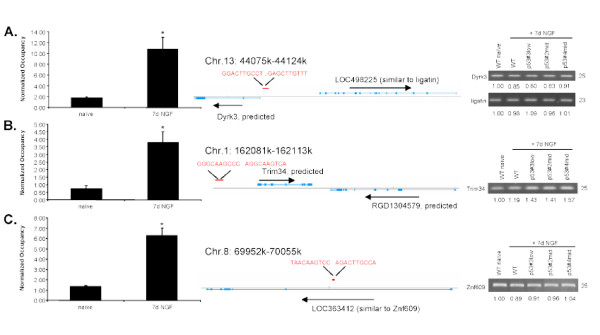
Additional targets with NGF-dependent increase in p53 occupancy, but where p53-dependent transactivation could not be clearly determined using anti-p53 shRNA expressing cell lines. Panels A-C show site-specific qPCR ChIP results on left with standard deviation, where significance at p ≤ 0.05 is designated by an asterisk (*). GAPDH controls in Figure 7 also apply to gene expression analyses in Figure 8. Note the p53-occupied sequence in Panel A lies between genes which were both examined for changes in expression. Display and analyses are as described in Figure 4 legend.